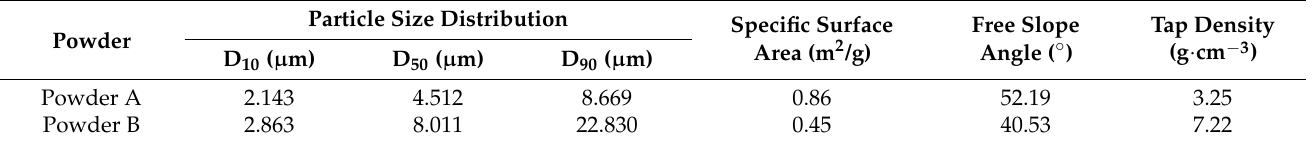
Table 2. Powder characteristics of W–20% Cu powders.